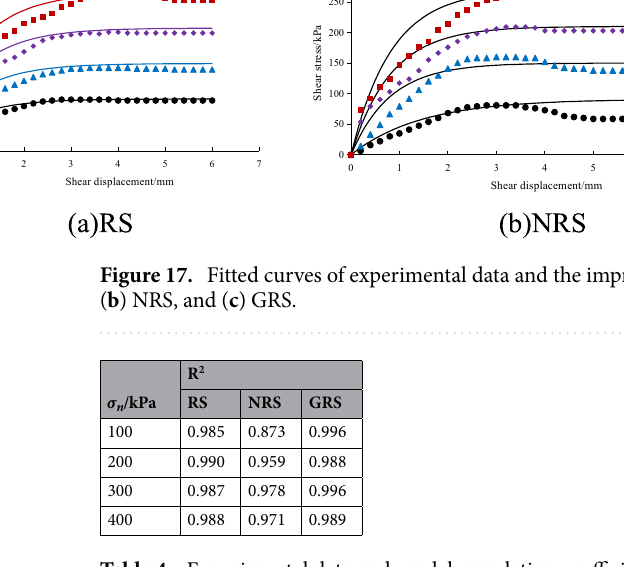
Table 4. Experimental data and model correlation